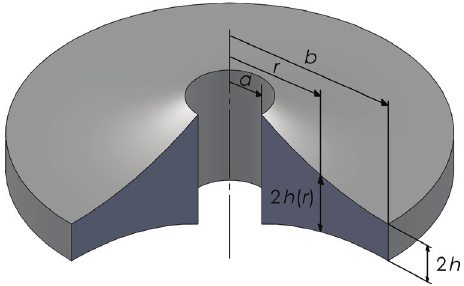
Figure 1 A thin radially FG circular plate with variable cross